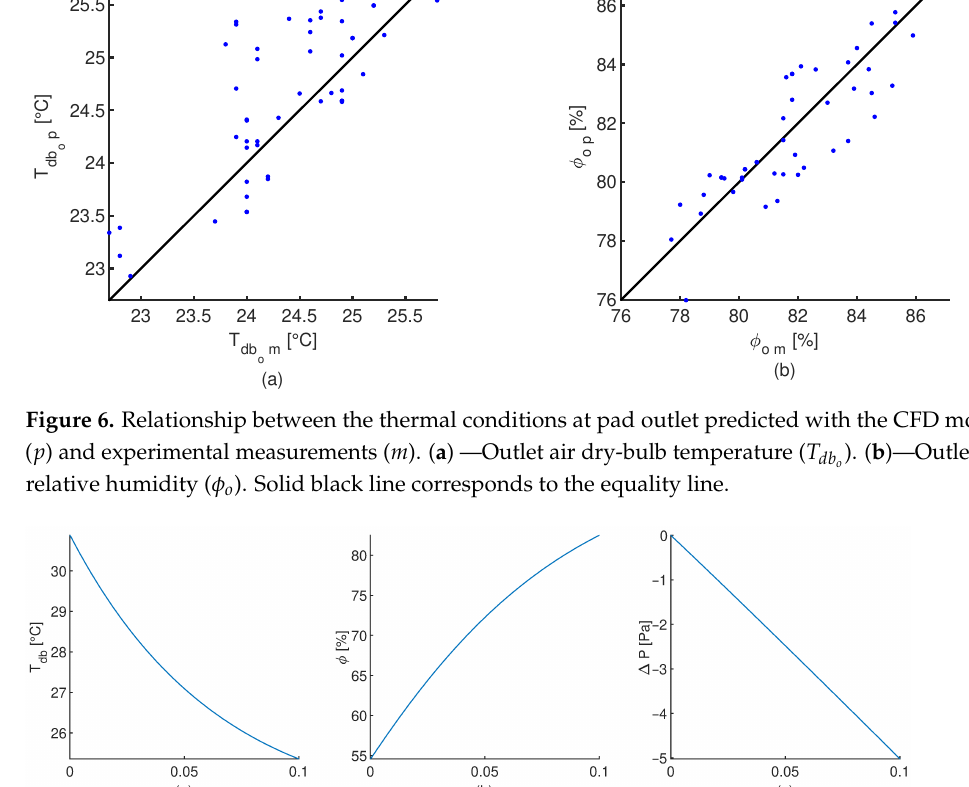
Figure 7. CFD predictions of the dry-bulb temperature ( a ), relative humidity ( b ) and pressure drop ( c ) changes inside the cellulose pad. For 30.9 ◦ C, 54.5% and 1.2 m s − 1 of dry-bulb temperature, relative humidity and velocity of the air at inlet pad,